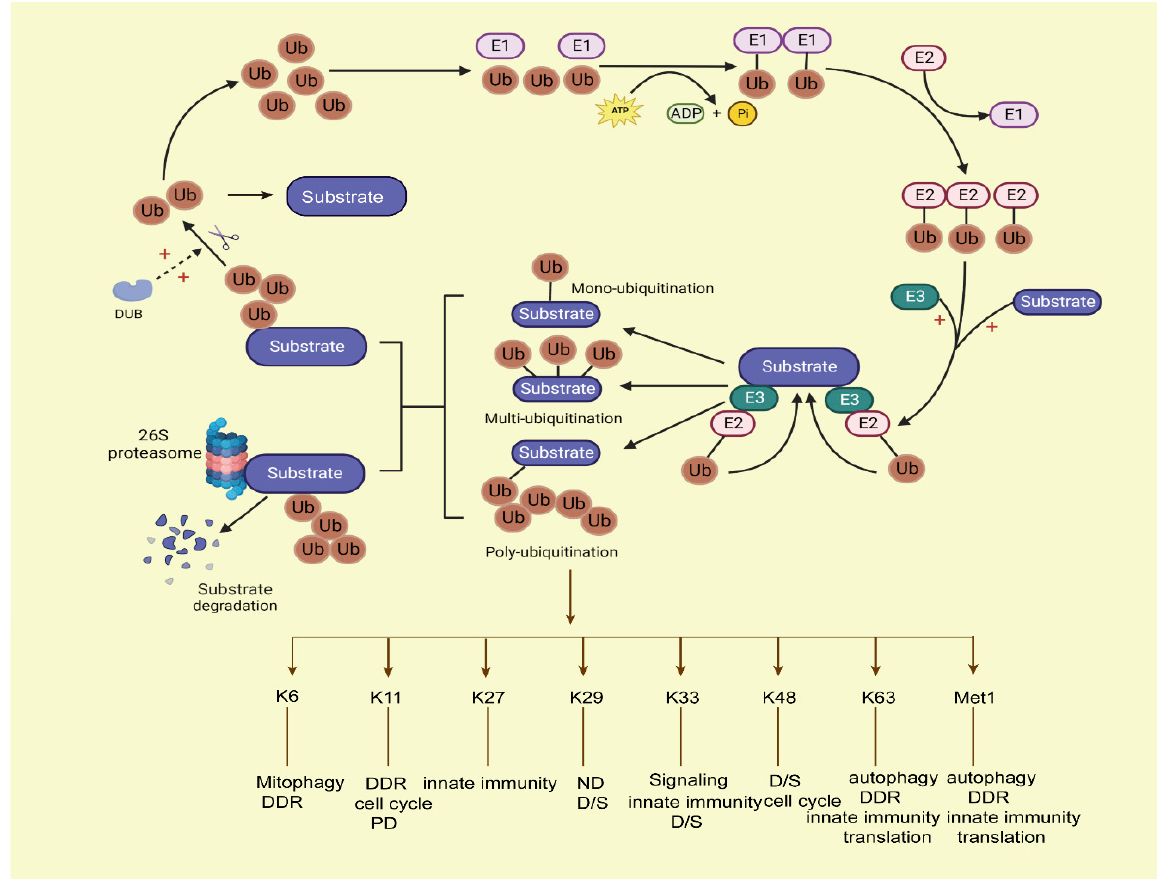
Figure 1. The process of the ubiquitin–proteasome system. Ubiquitination conjugation is initiated by activating enzyme E1, with ATP-dependent hydrolysis. Then, ubiquitin is transferred to E2, and E3 ligase cooperates with the E2 ligase ubiquitin complex onto the target substrates; the ubiquitins can covalently attach to each other by forming various linear or branched ubiquitin chains on the target substrates, forming mono-ubiquitination, multi-ubiquitination, and poly-ubiquitination ways of modification on substrates. Among them, the mono-ubiquitinated proteins cannot be degraded by proteasomes, and the substrates with at least four ubiquitins attached can be degraded by proteasomes. Then, the labelled substrates are recognized by the 26S proteasome and degraded. Deubiquitination enzymes (DUBs) can deconjugate ubiquitin from substrates to stabilize the protein levels of substrates and keep the balance of the ubiquitin pool in the human body. Ub, ubiquitin; DUB: deubiquitination